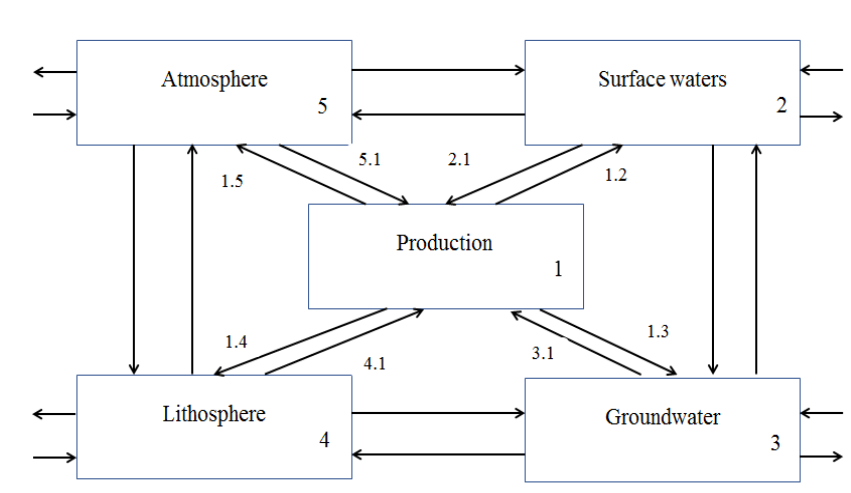
Fig. 2. ‘Chemical Plant-Environment’